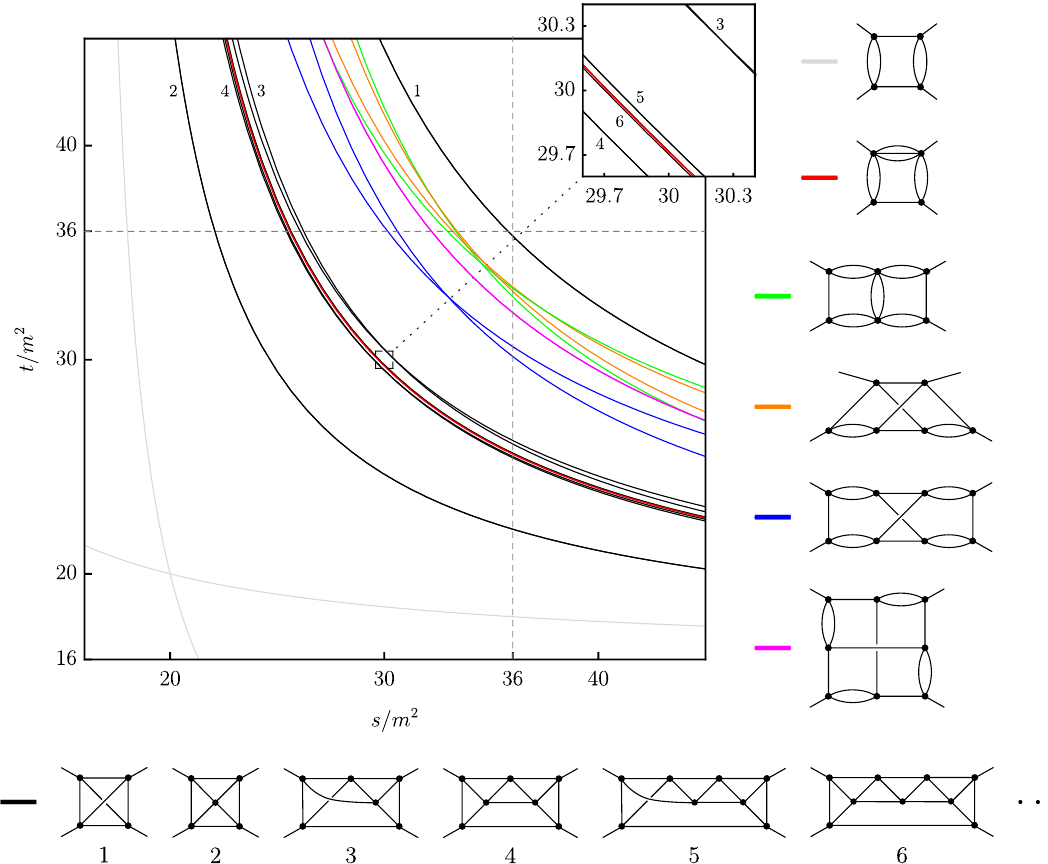
Figure 5: The Landau curves in the 2 → 4 multi-particle region. To each diagram corresponds a pair of crossing symmetry-related curves. For crossing symmetric di- agrams, there is only one curve. The red curve, given by equation (1), is an accu- mulation point of infinitely many Landau curves. The uppermost curve (black #1) is given by the non-planar cross diagram, figure 3 (b), while the planar cross, figure 3 (a), gives the lowermost curve (black #2). The planar triangle chain graphs (#2, #4, #6,...), figure 4 (a), approach the red curve from below while non-planar trian- gle chain graphs (#1, #3, #5,...), figure 4 (b), approach it from above. As